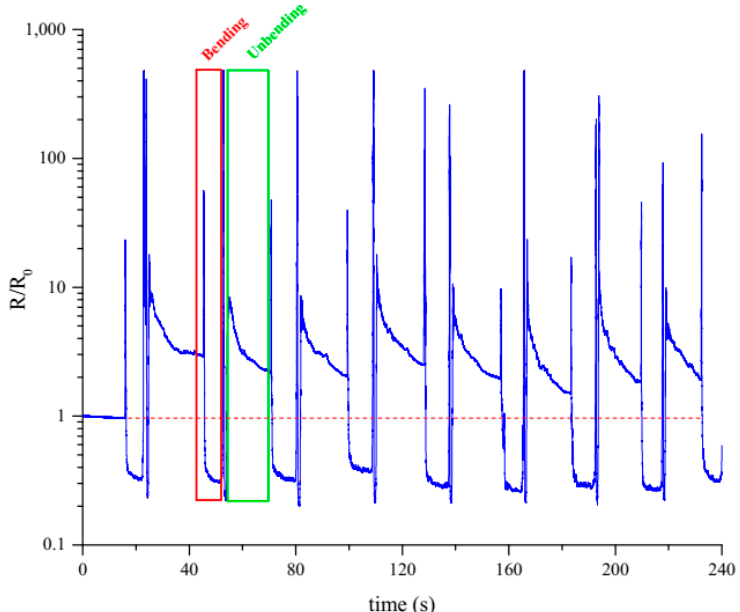
Figure 10. Normalized resistance during 90° bending and unbending of Ni-P plated PHNBR samples, in a logarithmic scale.